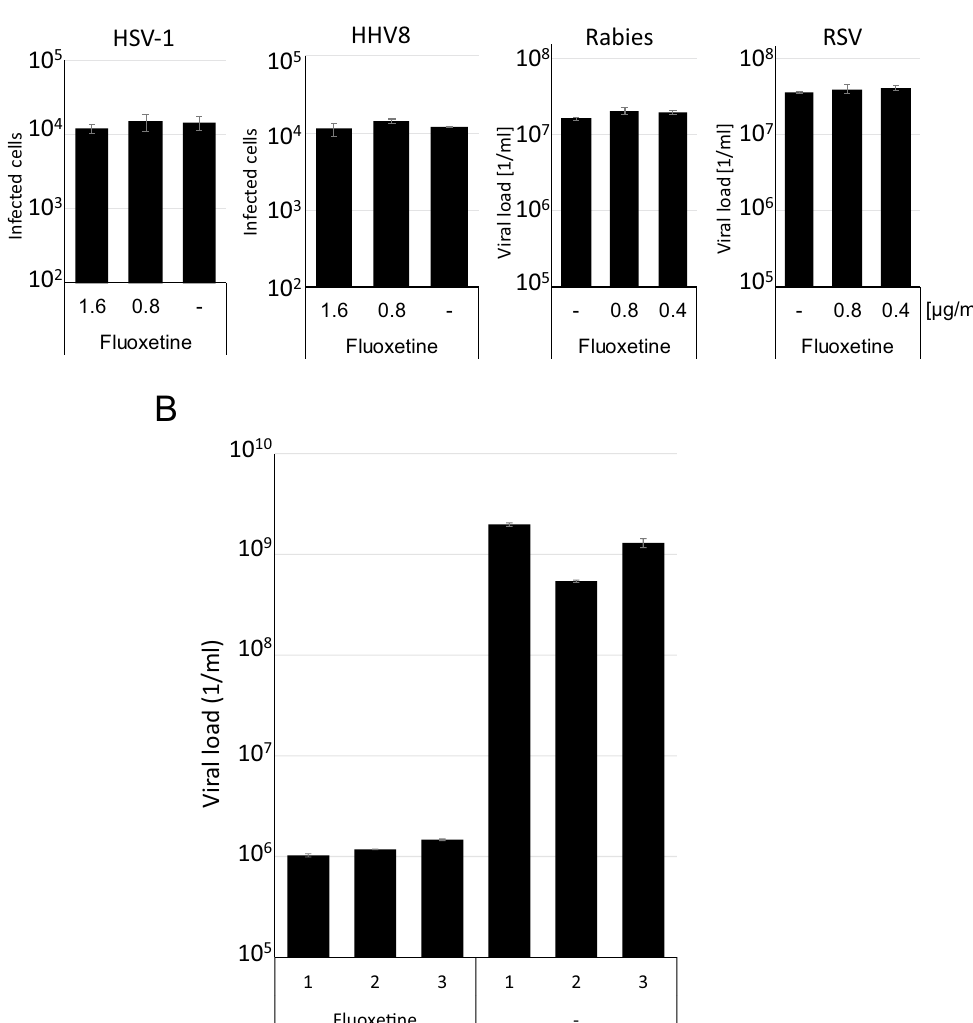
Figure 2. Fluoxetine inhibits virus replication specifically and SARS-CoV-2 in human lung tissue. ( A ) BHK21 and HepG2 cells were infected with either gfp -encoding HSV-1, HHV8, with a Rabies vaccine strain or with a patient-derived RSV. Viral titers were determined by RTqPCR (RSV, Rabies) or infected gfp -expressing cells were counted with an Ensight device (PerkinElmer). ( B ) Human precision-cut lung slices were treated with 1.6 µg/ml Fluoxetine infected with SARS-CoV-2. After 3 days virus, the supernatants were harvested, and viral infectivity was analysed by infecting Vero cells. The resulting viral load was determined by RTqPCR. Each bar represents the mean of 3 RTqPCR reactions from a single PCLS. The error bars represent the standard